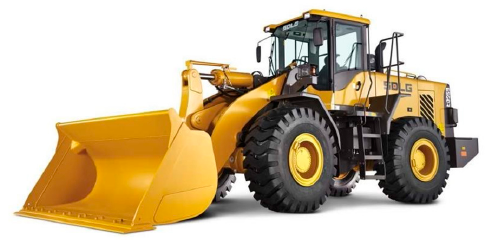
Figure 3. Objective wheel loader.